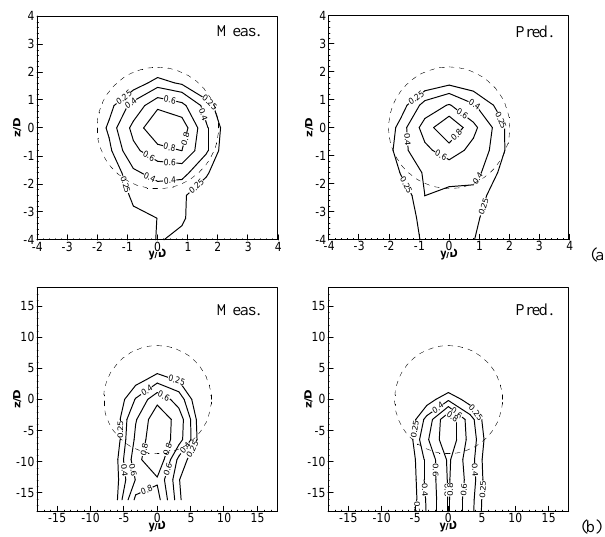
Fig. 4. 2D sediment deposition pattern for (a) glass particles 215 µ m, u 0 = 0 . 59 m/s, w s = 2 . 65 cm/s, (b) plastic IP3 particles 716 µ m, u 0 = 0 . 79 m/s, w s = 2 . 02 cm/s. Contours in g/m 2 /s.